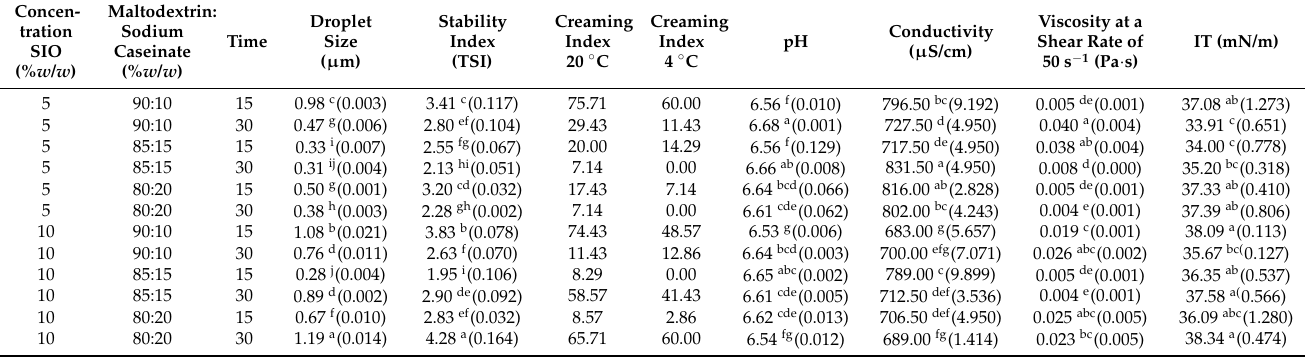
Table 2. Experimental design for preparation of emulsions with an ultrasound probe and physic- ochemical properties evaluated: droplet size, stability index, pH, conductivity, viscosity, and interfacial tension